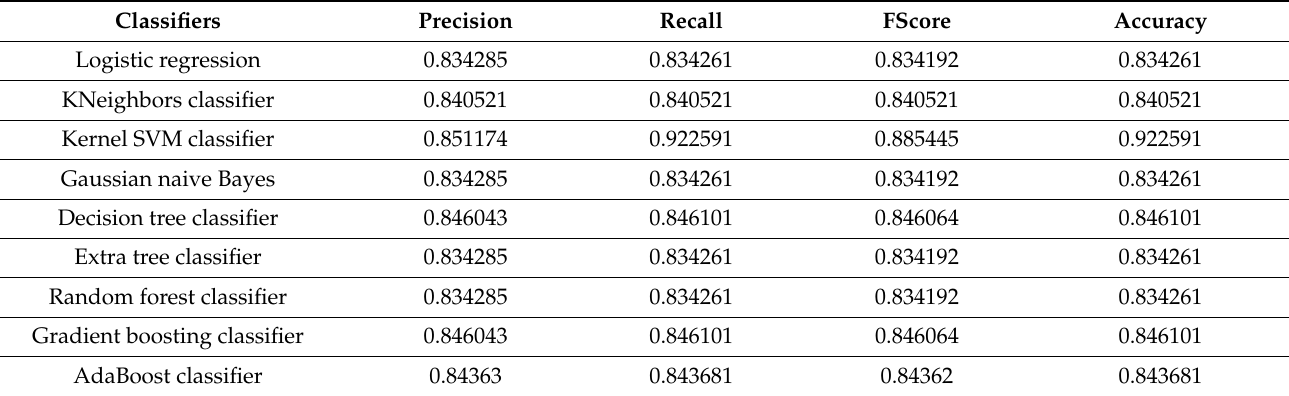
Table 2. Classification metrics before feature